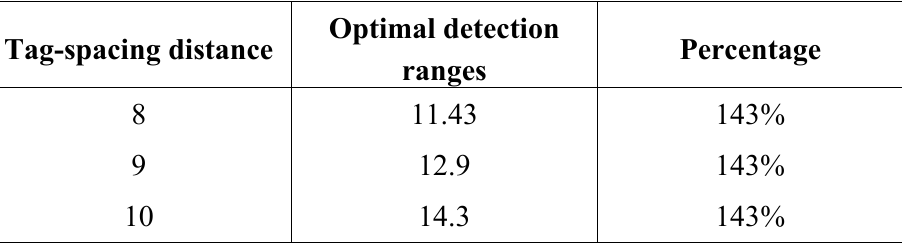
Table 4. Optimal detection ranges in a 3-dimensional